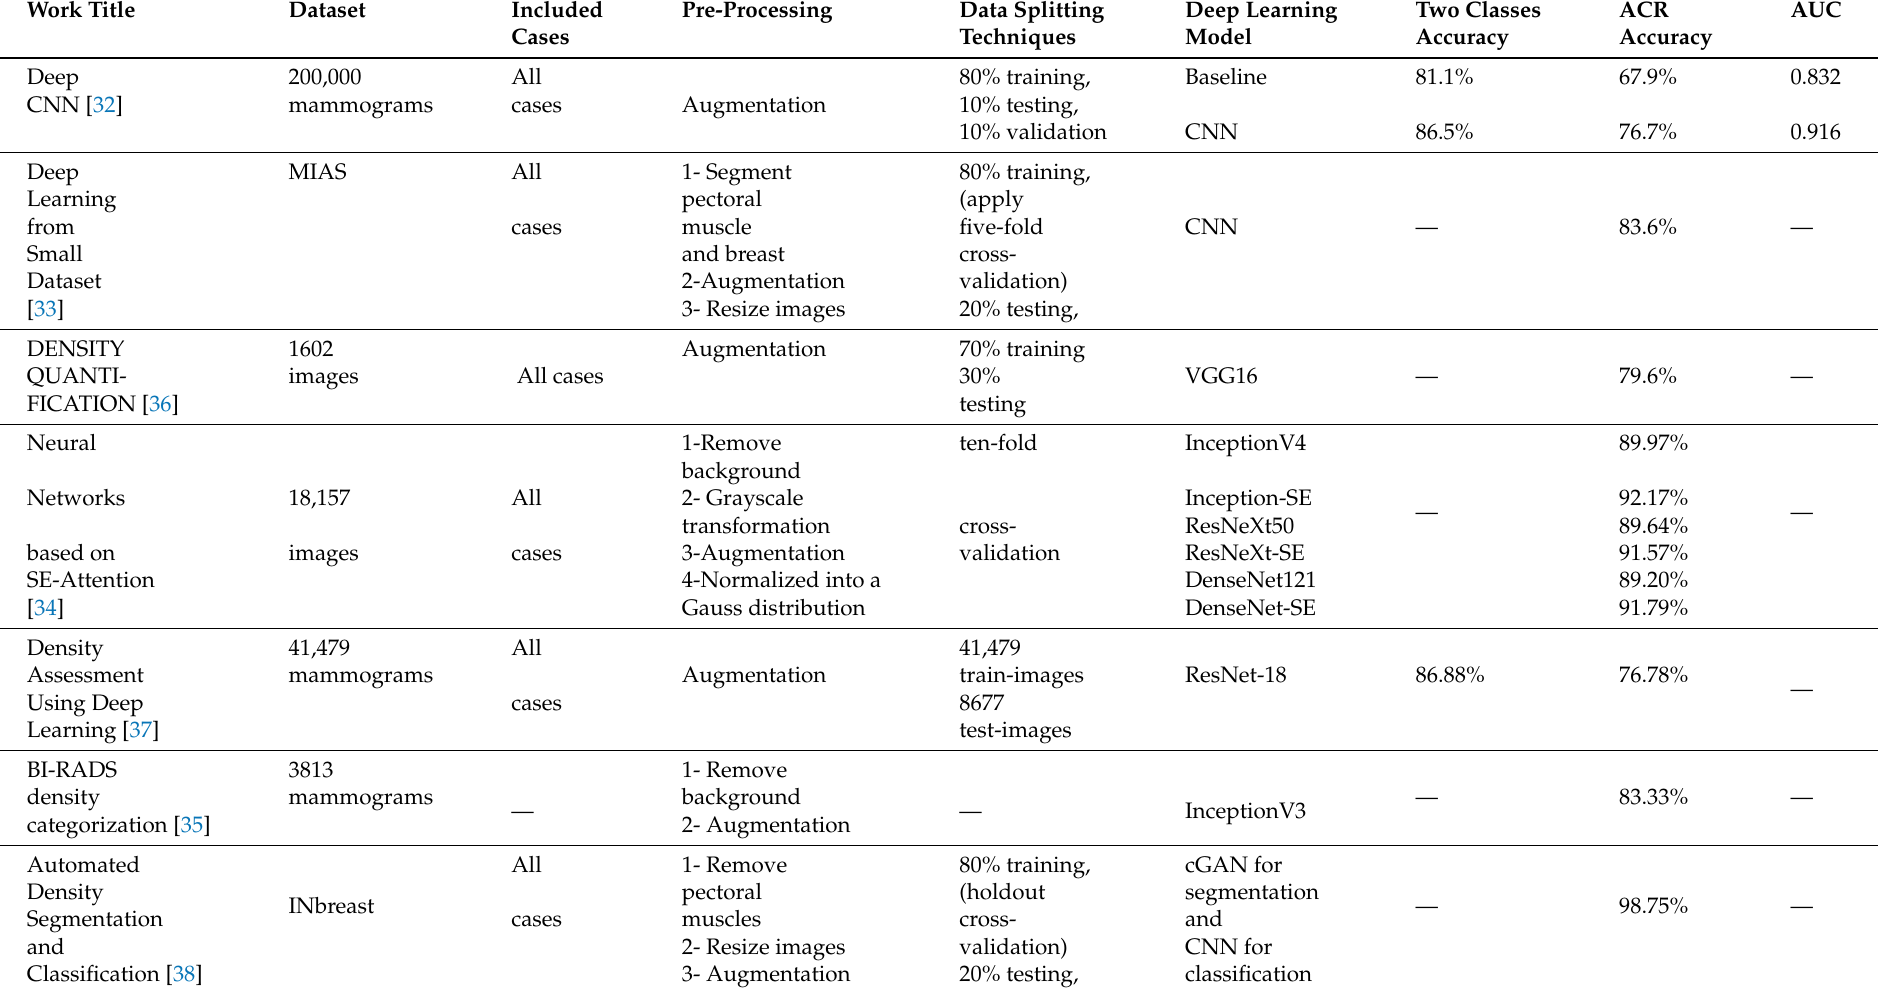
Table 3. Classifying breast density using deep